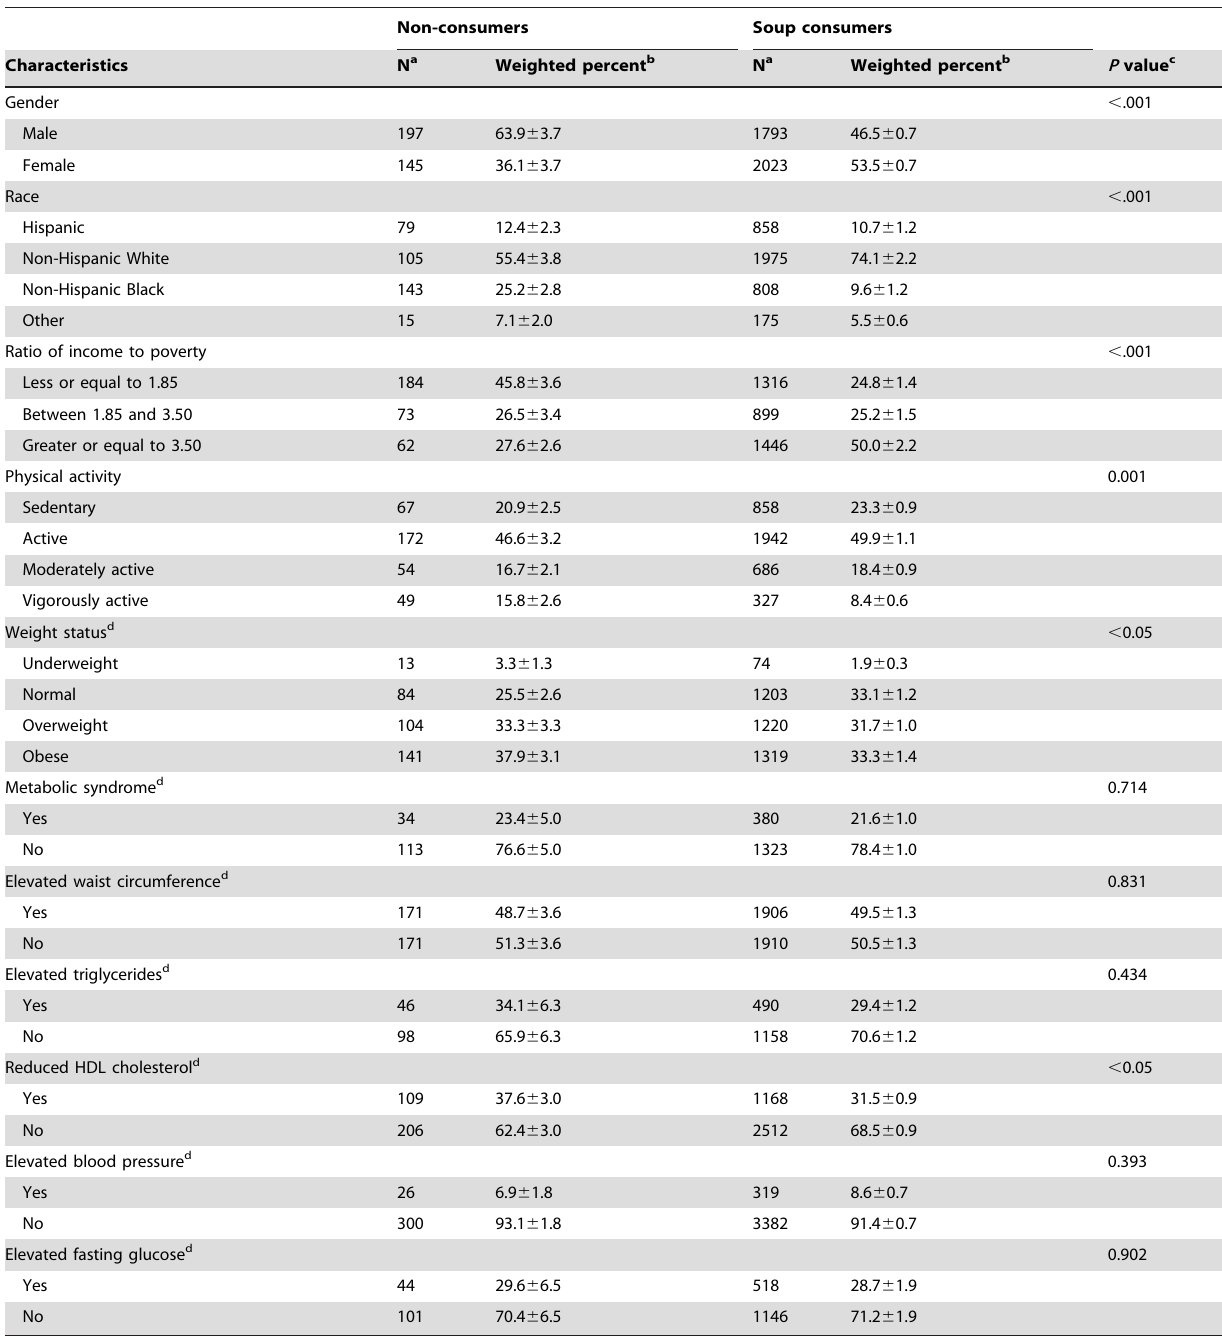
Table 1. Characteristics of